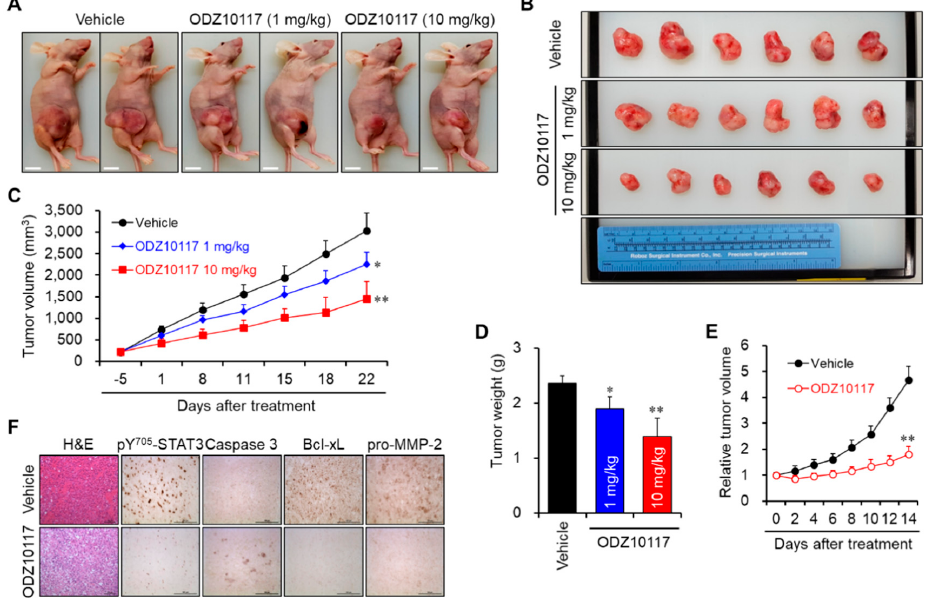
Figure 7. ODZ10117 suppressed tumor growth in breast cancer xenograft models. ( A – D ) Orthotopic xenograft model was generated by injection of MDA-MB-231 cells into the right fourth mammary fat pad of female BALB/c mice. The tumor growth ( A ), tumor size ( B ), tumor growth curve ( C ), and tumor weight ( D ) were represented. ( E , F ) Subcutaneous xenograft model was established by injecting MDA-MB-231 cells in suspension with 25% Matrigel-containing PBS into the neck of female BALB/c nu/nu nude mice. The tumor growth curve ( E ) and IHC analysis ( F ) were represented. * p < 0.05 and ** p < 0.005 compared to the vehicle-treated group.